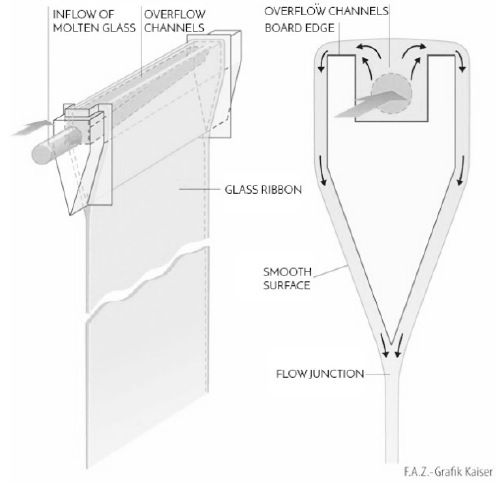
Fig. 3 Overflow-fusion process. (Kueffner